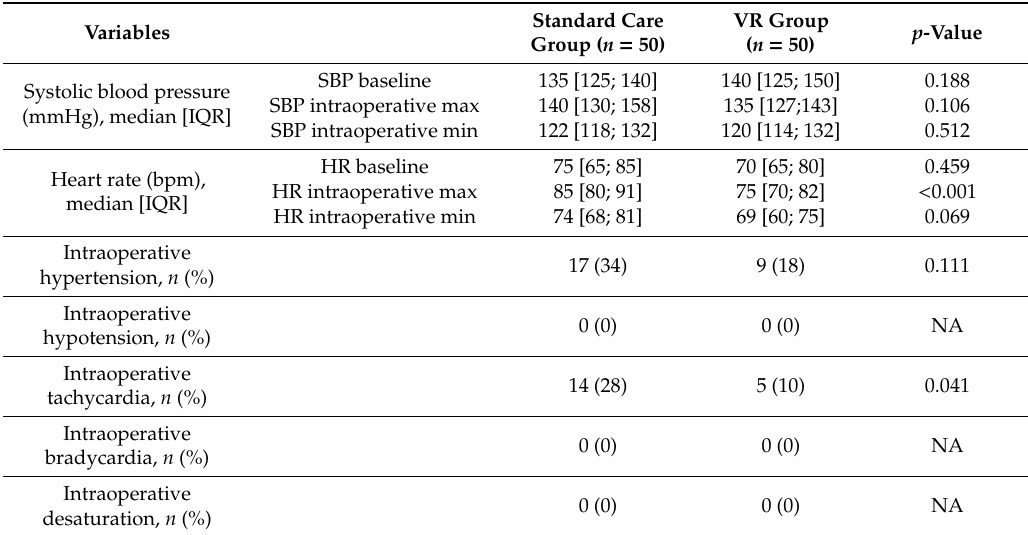
Table 2. Perioperative hemodynamic vital